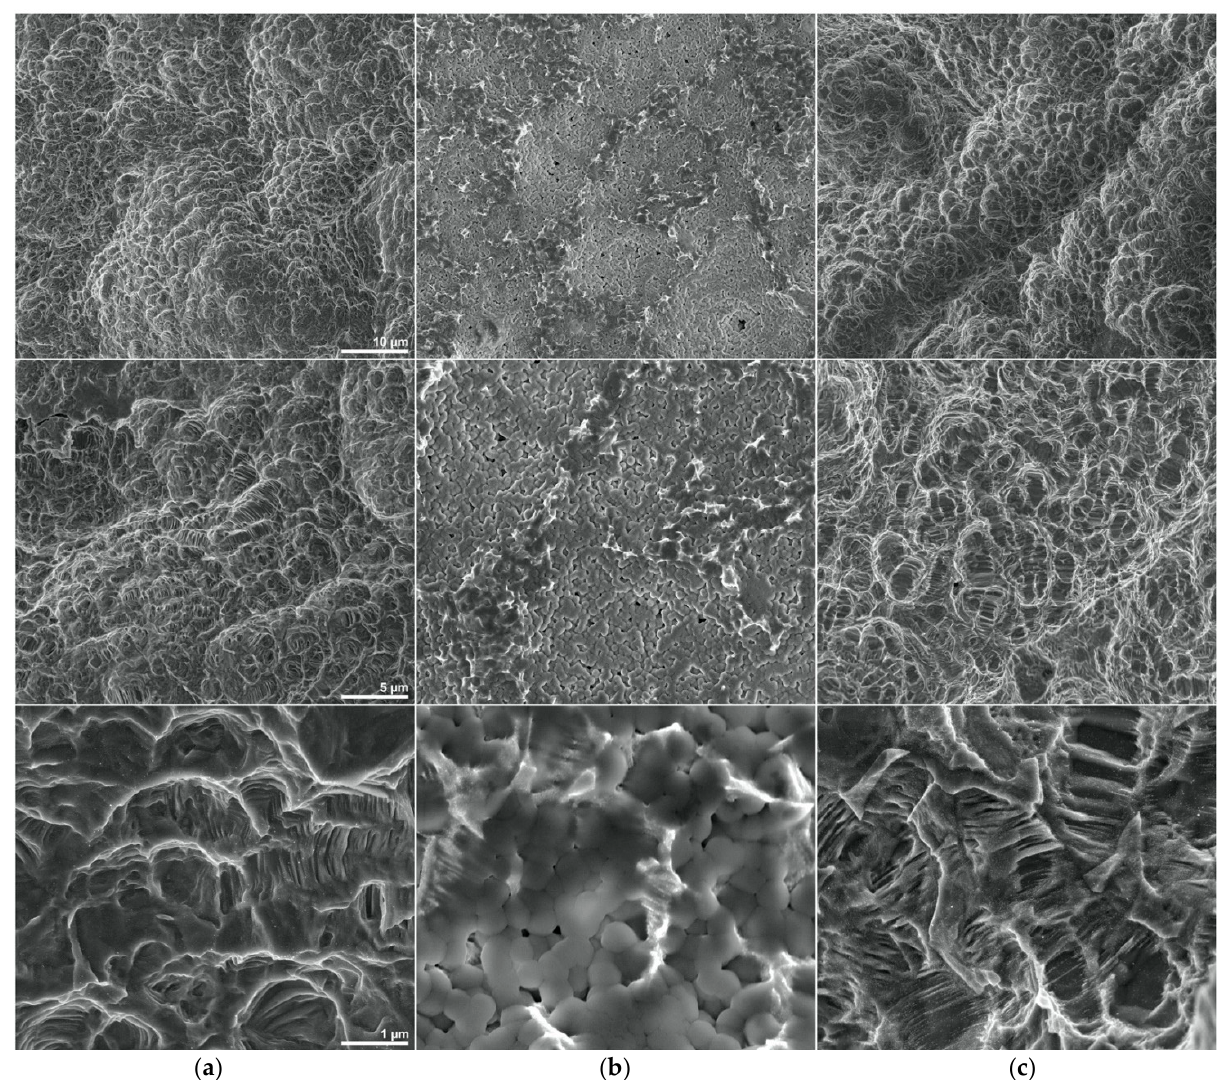
Figure 2. SEM micrographs illustrating the surface topology and roughness of ( a column ) ABT, ( b column ) Nano and ( c column ) Nano H 2 O discs at high magnification (horizontal field widths of 59.7 µm, 29.8 µm and 5.97 µm, respectively). The magnifications are 5000×, 10,000× and 50,000×, respectively for the first, second and third line of photos.